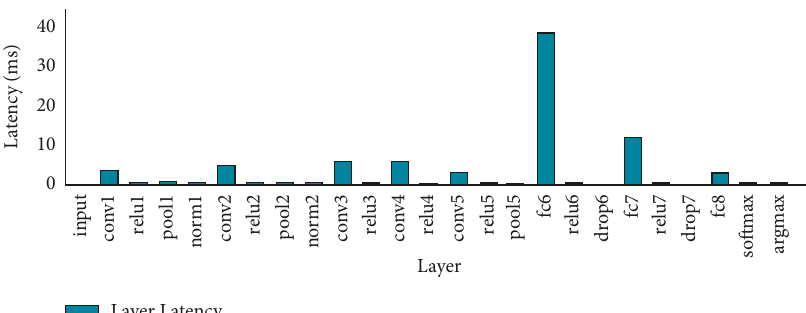
Figure 6: The delay size analysis of each layer of the AlexNet neural network.